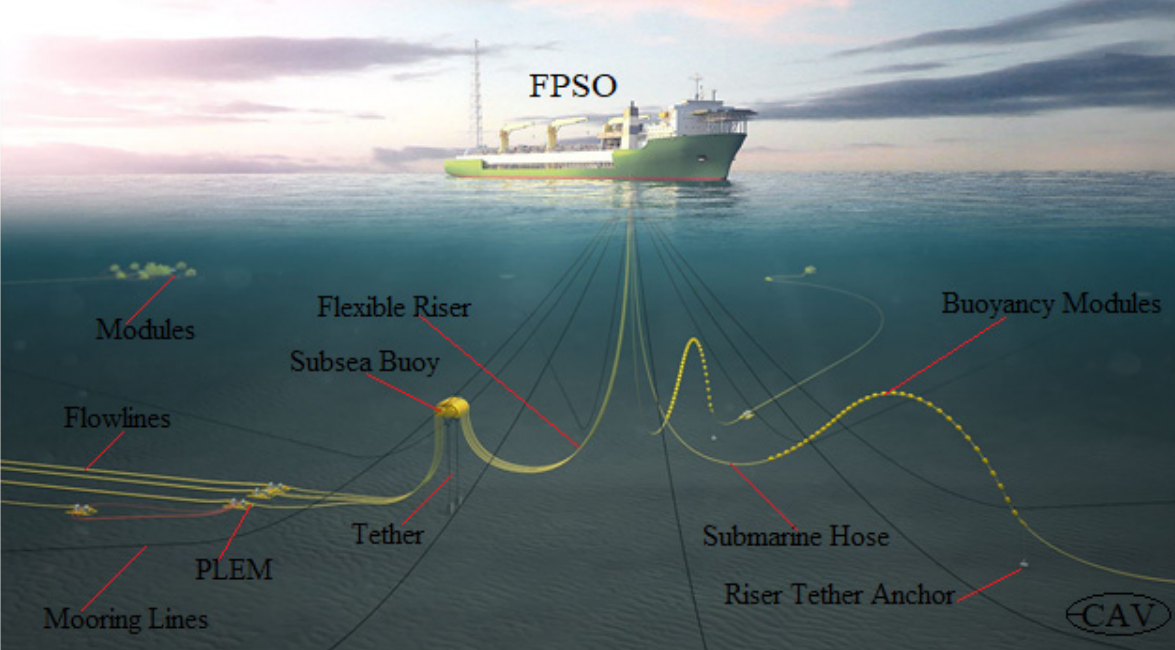
Figure 8. An internal turret FPSO with multiple marine hoses and flexible risers showing different configuration and the following components: modules, flowlines, flexible riser, subsea buoy, tether, PLEM, mooring lines, submarine hose, riser tether anchor, buoyancy modules and internal turret system.